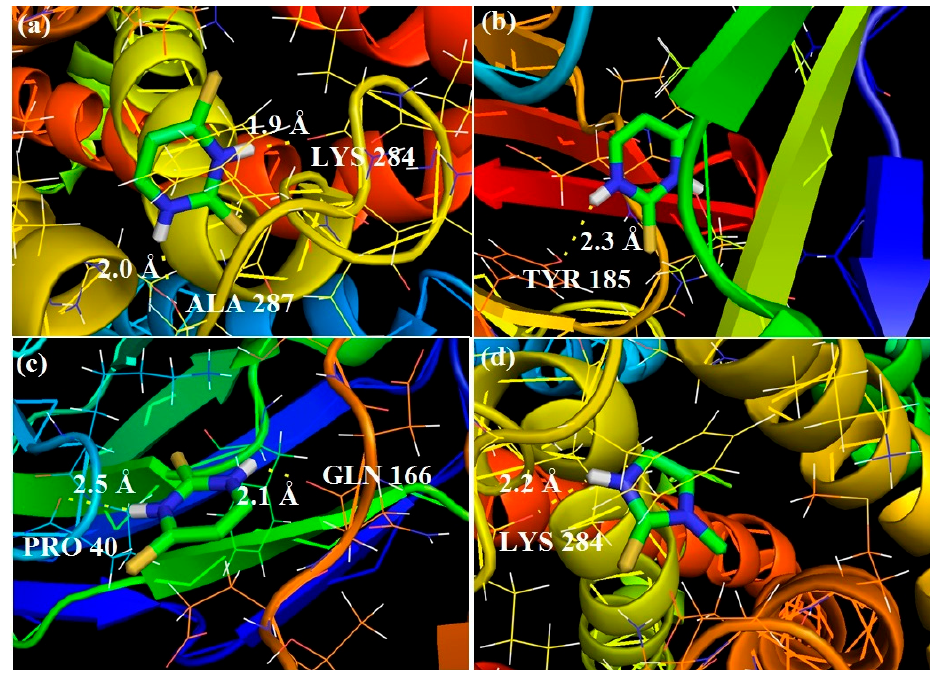
Figure 6. Lowest energy docked poses of the 2,4DTU ligand with various targeted proteins such as ( a ) NIS, ( b ) TSHR, ( c ) TPO and ( d ) lowest energy docked pose of the MMI ligand with the targeted protein NIS.